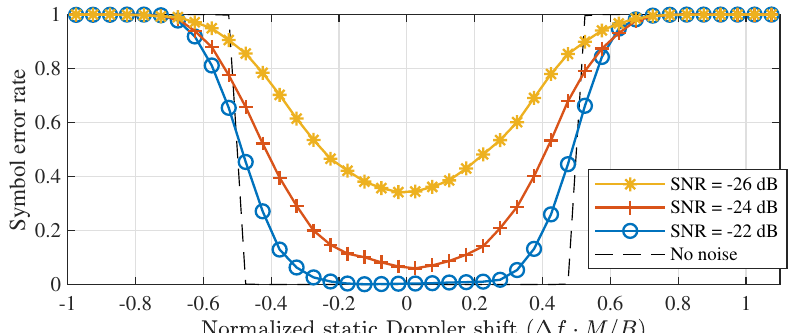
Figure 3. Symbol detection performance for static Doppler shifts with a perfectly time-aligned down-chirp. (SF = 12, B =